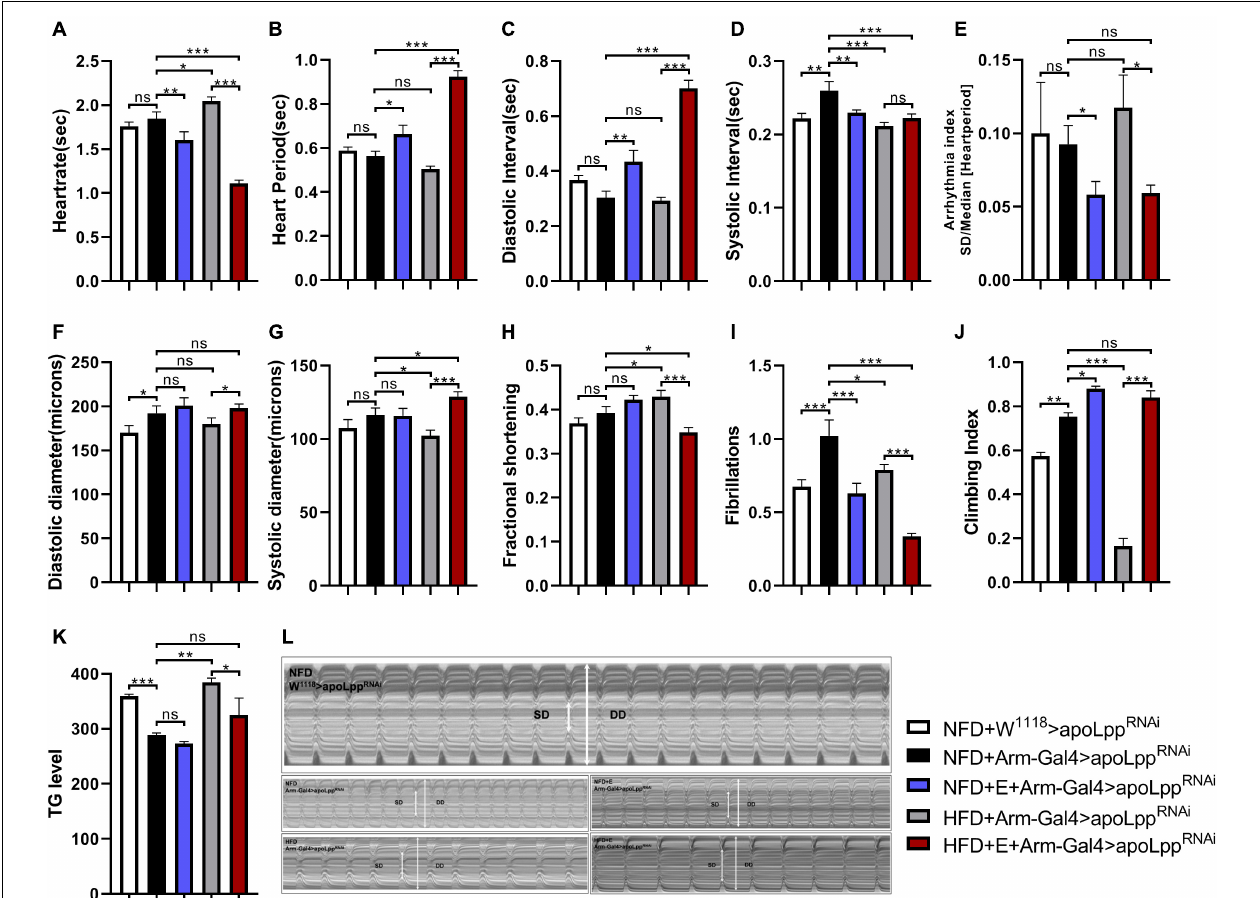
FIGURE 3 | The effect of whole-body inhibition of apoLpp on the heart function, exercise capacity, and TG levels of each group of Drosophila . (A–I) Under different treatments, the M-mode indicators are HR, HP, DI, SI, AI, DD, SD, FS, and FL. All flies were females, The sample sizes, NFD + w 1118 > apoLpp RNAi , NFD + Arm-Gal4 > apoLpp RNAi , NFD + E + Arm-Gal4 > apoLpp RNAi , HFD + Arm-Gal4 > apoLpp RNAi , and HFD + E + Arm-Gal4 > apoLpp RNAi are N = 16, 18, 14, 17, and 22. (J) Represents the locomotor ability of flies under different treatments. The value of the histogram is the climbing index of the flies. For the calculation of the climbing index, see section “Materials and Methods.” All flies were females, N = 50. (K) Whole-body TG levels in flies under different treatments. The bar graph value is the original OD value/fly’s body weight. All samples were females, N = 5, and the measurement was repeated three times. (L) M-mode cardiogram of Drosophila under different treatments. The short arrow is the systolic diameter, the long arrow is the diastolic diameter, and the rectangle is the fibrillary tremor. The interception of M-mode cardiogram for each group was 10 s. Independent sample t -test was used to identify differences between NFD + w 1118 > apoLpp RNAi flies and NFD + Arm-Gal4 > apoLpp RNAi . A two-way ANOVA was used to identify differences among the NFD, NFD + E, HFD, and HFD + E groups in Arm-Gal4 > apoLpp RNAi flies. * P < 0.05, ** P < 0.01, *** P <